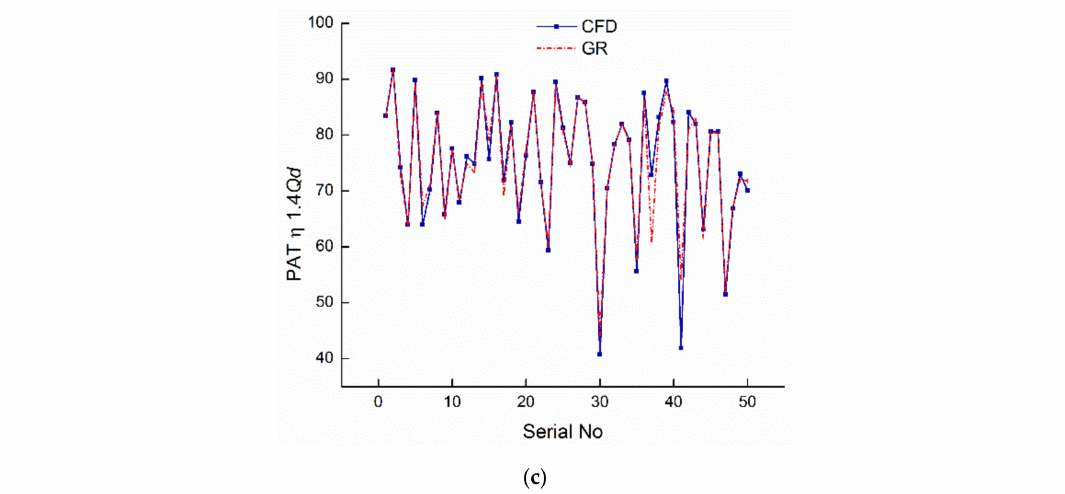
Figure 15. Validation of GRNN prediction with CFD: ( a ) 0.6 Q d , ( b ) 1.0 Q d, and ( c ) 1.4 Q d.